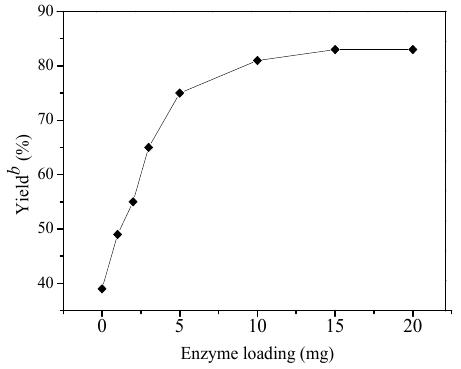
Figure 4. Reaction yields at different enzyme loadings a . a Reaction conditions: 2-aminoacetophenone (0.3 mmol), ethyl acetoacetate (0.36 mmol), and α -chymotrypsin (0, 1, 2, 3, 5, 10, 15, 20 mg/mL) in 20% ([EMIM][BF 4 ]/(H 2 O + [EMIM][BF 4 ]), v / v ) IL aqueous solution at 55 °C for 24 h. b Isolated yield after column chromatography. Table 1. Substrate scope of α -chymotrypsin-catalyzed Friedländer condensation in an IL aqueous solution a .